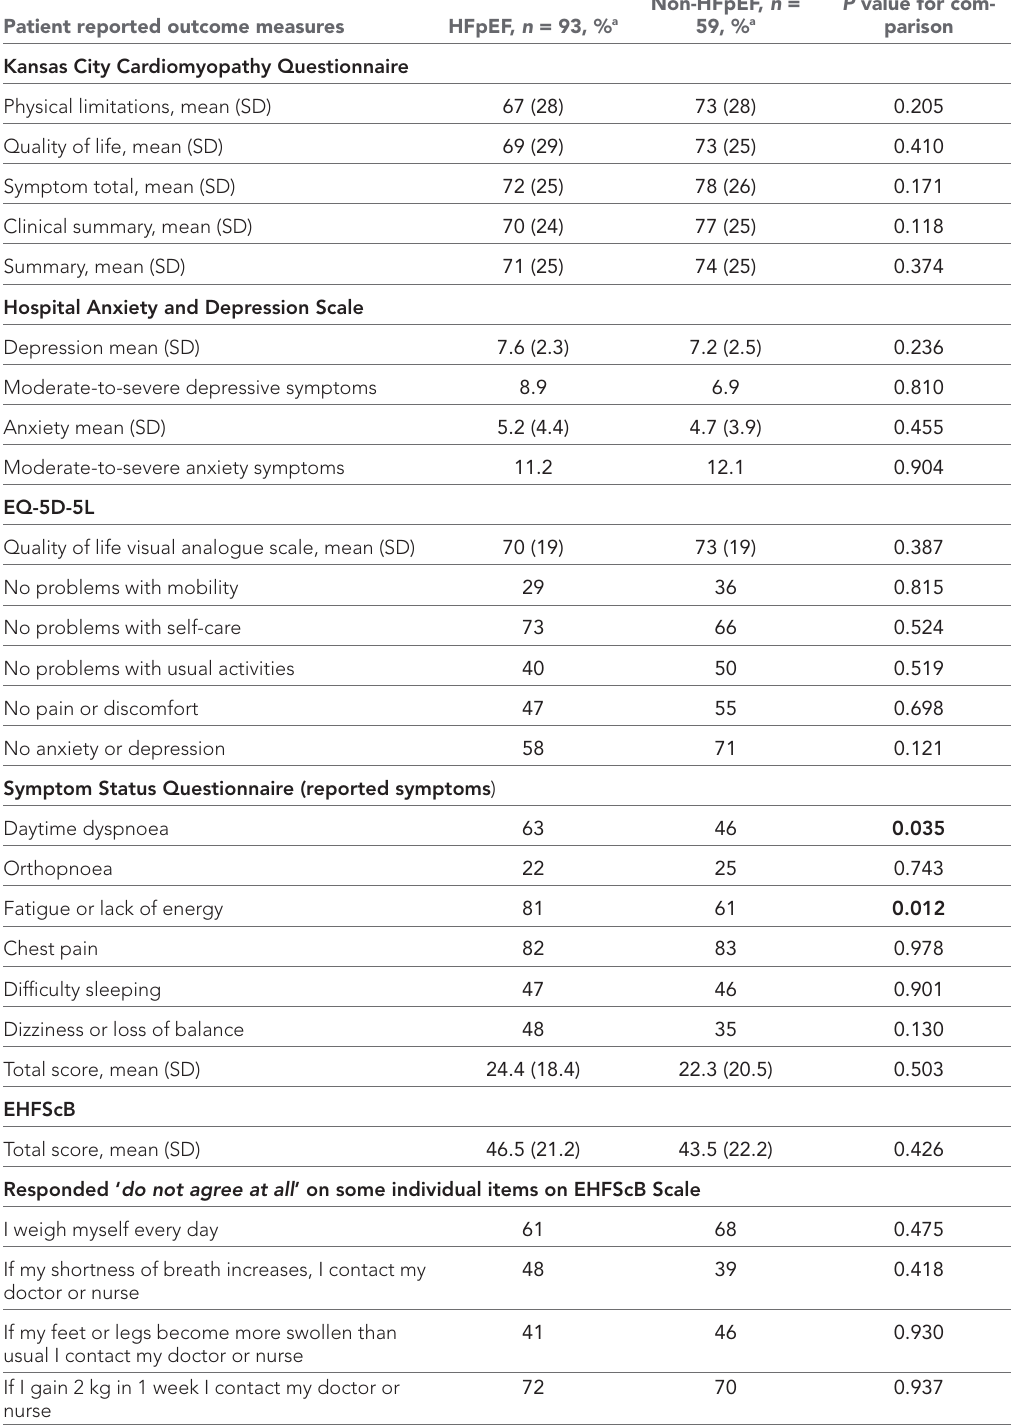
Table 3 Patient reported measures by HFpEF